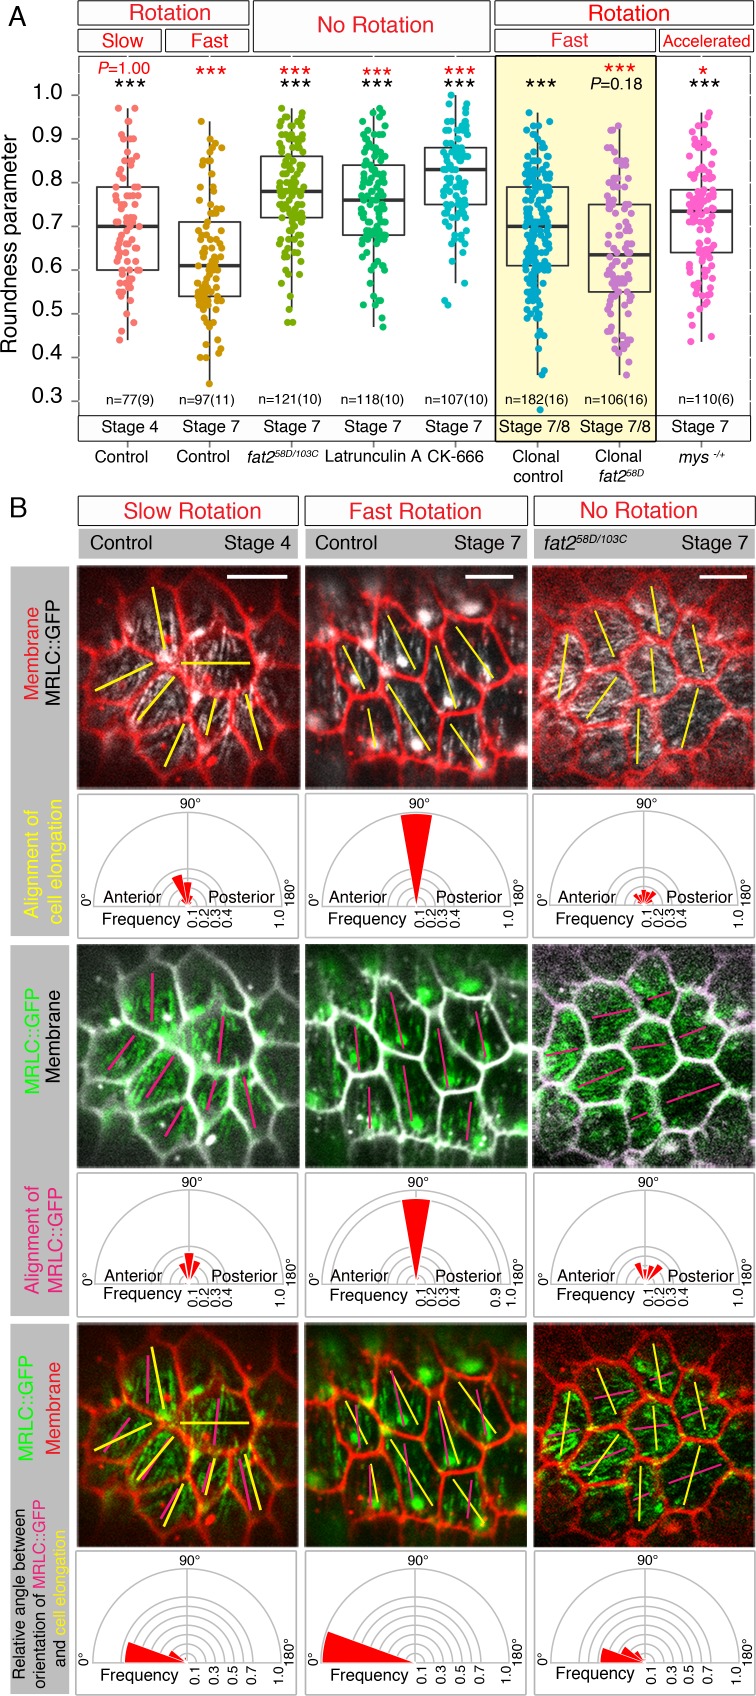
Epithelial rotation is required for the directed elongation of follicle cells.(A) Comparison of roundness parameter (Material and Methods) of follicle cells with different migratory speed: slow migrating follicle cells (control stage 4), fast migrating follicle cells (control stage 7), follicle cells in the static follicle epithelium (fat2 mutant follicle cells), follicle cells depleted for actin, Latrunculin A and depleted for Arp2/3 complex, CK-666, migrating fat2 mutant follicle cells in small clones and their migrating control neighbours (in yellow panel) and follicle cells with accelerated migration (mys heterozygous mutants). *** = P<0.001, * = P<0.05. Note that the roundness parameter of analyzed categories was statistically compared to the one with no indicated stars. Black P-values indicate how the roundness parameter differs from the control stage 7 (fast epithelial rotation). Red P-values show how the roundness parameter differs from the clonal control stage 7/8 (fast epithelial rotation in the fat2 mutant mosaic eggs chambers). (B) Angular distribution of alignment of cell elongation and of MRLC::GFP movement expressed as frequencies in 20°-bin-rose diagrams are shown for slow (control stage 4), fast (control stage 7) and no (fat2 mutant of stage 7) epithelial rotation. Yellow bars show the direction of follicle cell elongation and berry-coloured lines the direction of local Myo-II in the range of 0°-180°. Scale bars = 5μm. Anterior is on the left.